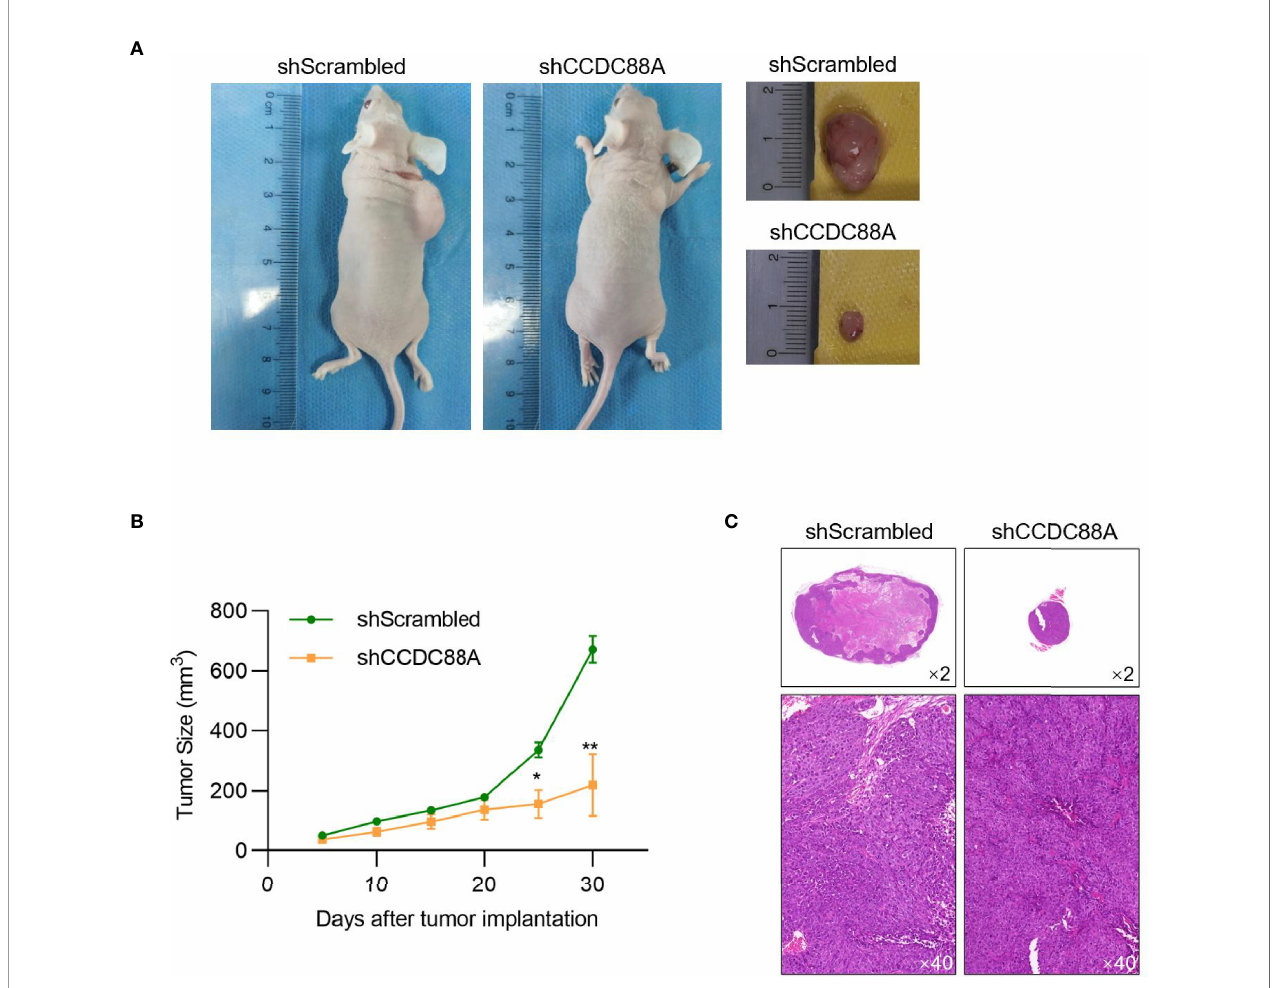
FIGURE 6 | CCDC88A knockdown decreased tumor formation in nude mice. (A) 30 days after injection, grafting tumors were obtained and the tumor size of each mouse was measured every fi ve days. N=4 for each group. *P < 0.05, vs. shScrambled group; **P < 0.01, vs. shScrambled group. (B) Body weight of each mouse was measured every fi ve days. (C) H&E staining in each grafting tumor was